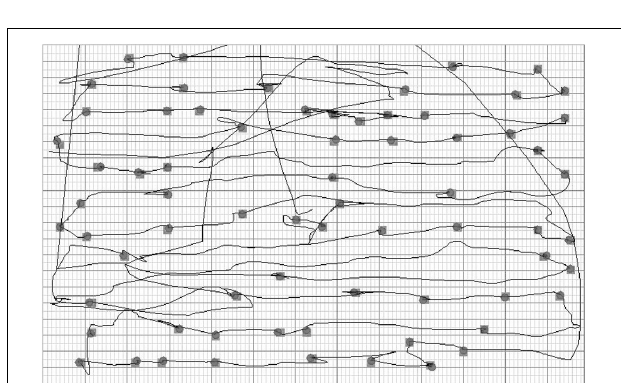
FIGURE 2 | The large-screen Twinkle Task: visualization of the scanning pattern and the selected targets in a representative patient.